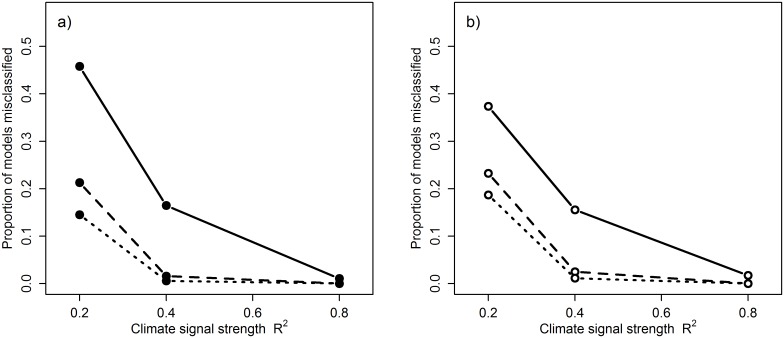
Relationship between climate signal strength (R2) and misclassification rate of climate signals.Misclassification rate (false negative) calculated using the metric PC at sample sizes of 10 (solid line), 30 (dashed line) and 47 (dotted line) with a) no cross-validation and b) 10-fold cross-validation.